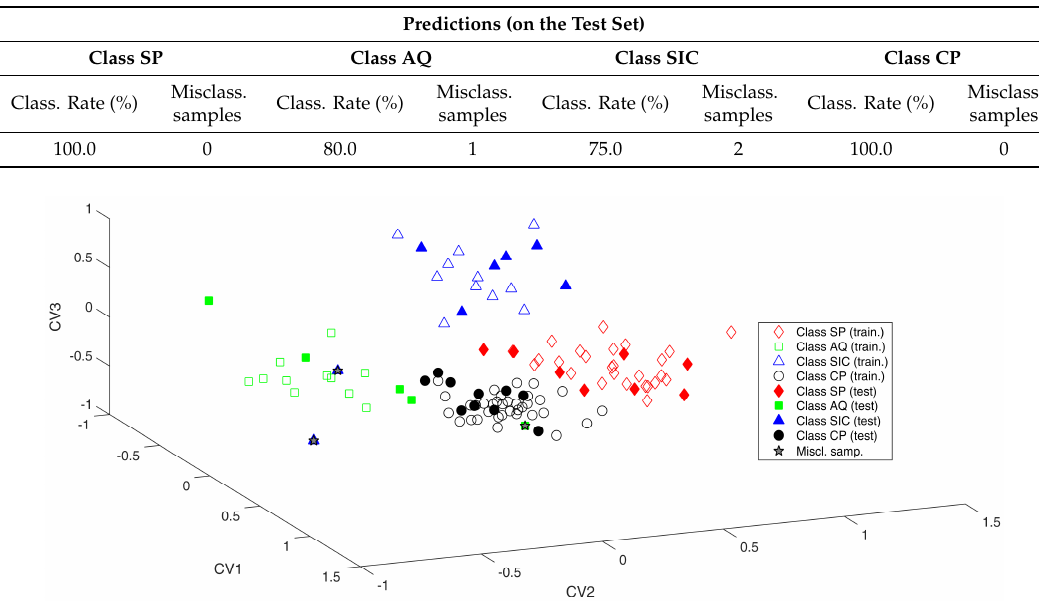
Sequential and Orthogonalized Partial Least Squares Linear Discriminant Analysis (SO-PLS-LDA) analysis: External Validation. Correct classification rates (%) and number of misclassified test samples.